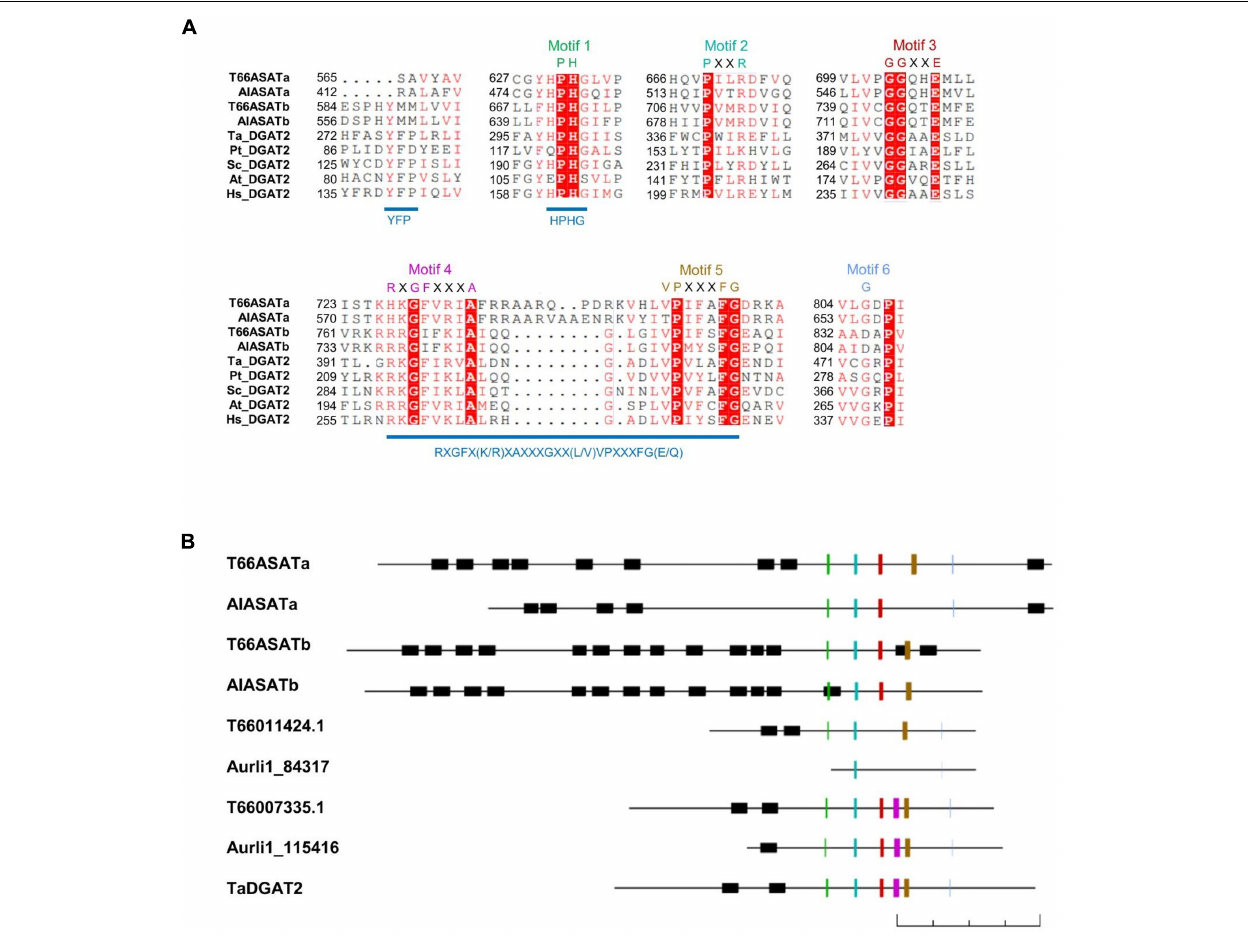
FIGURE 3 | (A) Sequence alignment of T66ASATa, T66ASATb, AlASATa, and AlASATb with the conserved parts of DGAT2 from some species. The alignment was generated by ClustalW, illustrated by ESPript 3.0 (Robert and Gouet, 2014). The first two letters denote the species encoding the selected proteins from Figure 2 : T. aureum , P. tricornutum , S. cerevisiae , A. thaliana , and H. sapiens . White letters with a red background denotes consensus residues, red letters: identical or similar residues, Motif 1–6: DGAT2 conserved motifs, see the text. (B) Schematic representation of the DGAT2-like proteins identified in T66 and SR21, and a function-verified TaDGAT2, oriented with the N-terminus to the left and the C-terminus to the right. All proteins are drawn in scale by Clone Manager with the lengths indicated by a 200 amino acids scale bar at the bottom. Black boxes: transmembrane domains predicted by TMHMM (Sonnhammer et al., 1998), colored lines: DGAT2 conserved Motif 1–6 with colors as indicated in (A) .